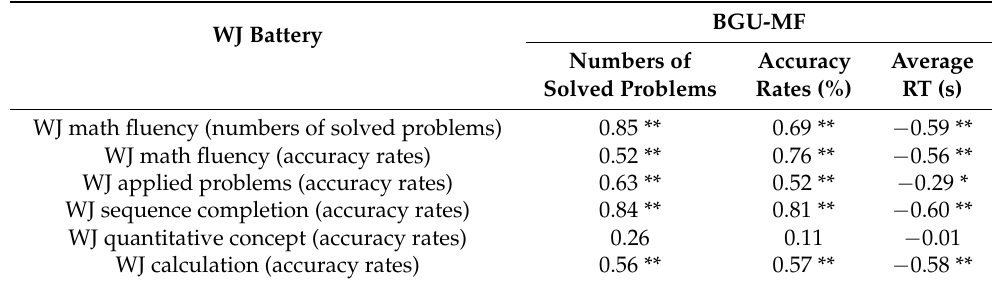
Figure 6. Accuracy rates in both formats of the math fluency tests. Table 1. Correlation coefficient (r) results between the BGU-MF test and the Woodcock–Johnson bat- tery. WJ Battery